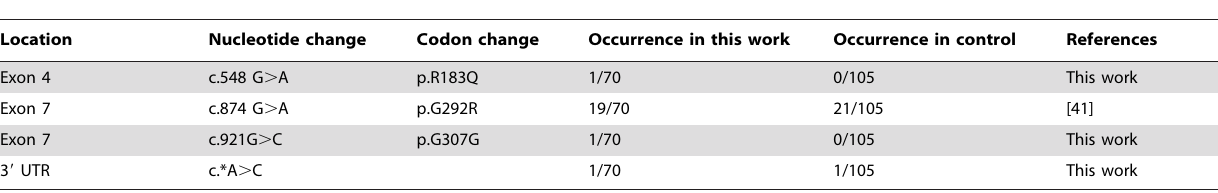
Table 2. Genetic variants of PJVK identified in 76